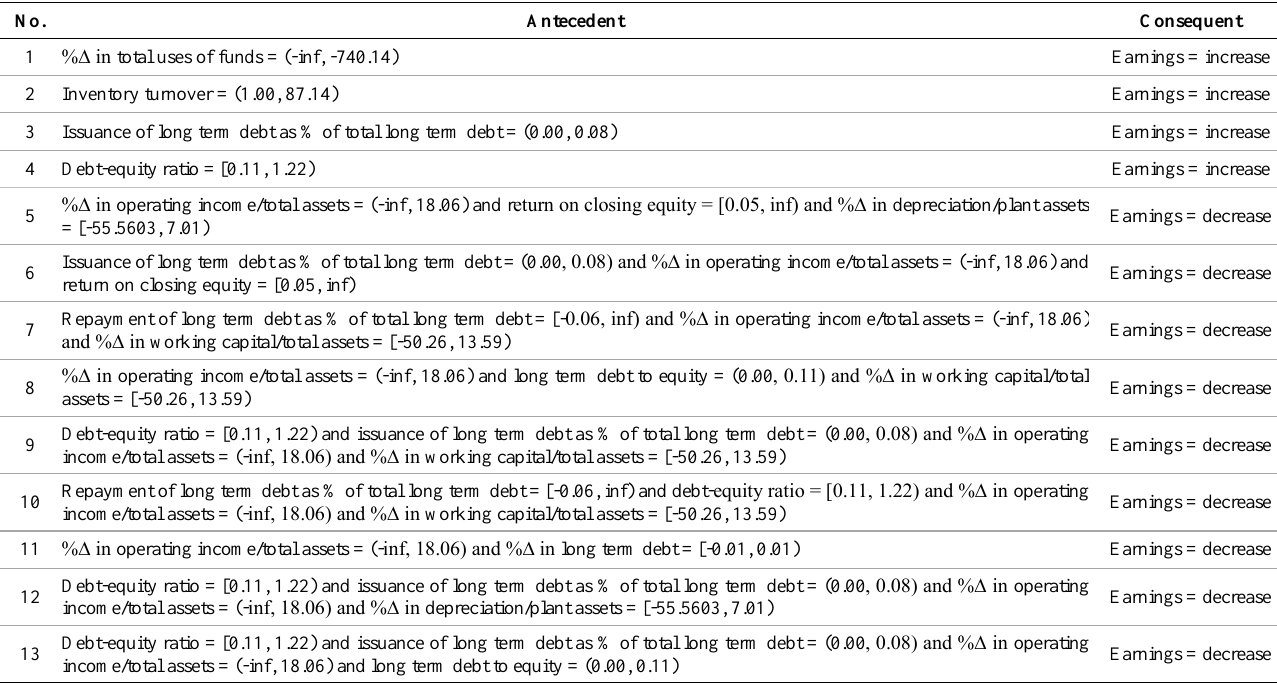
Table 8. Strong associated patterns of increased and decreased earnings from both